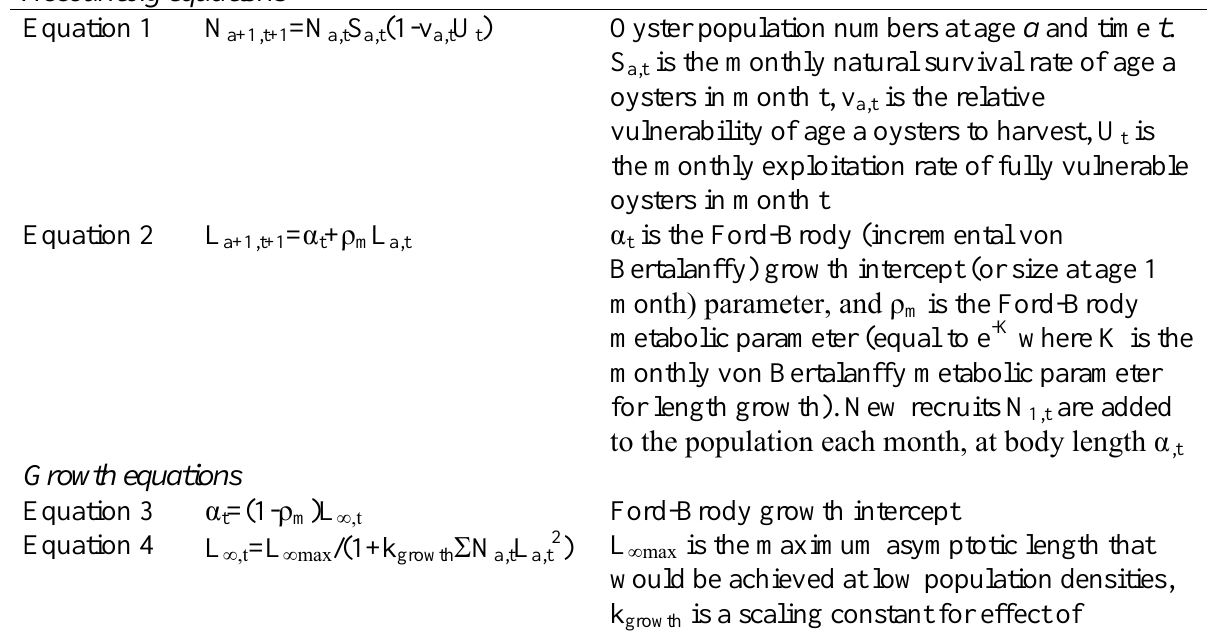
Table A2.1. Model equations Accounting